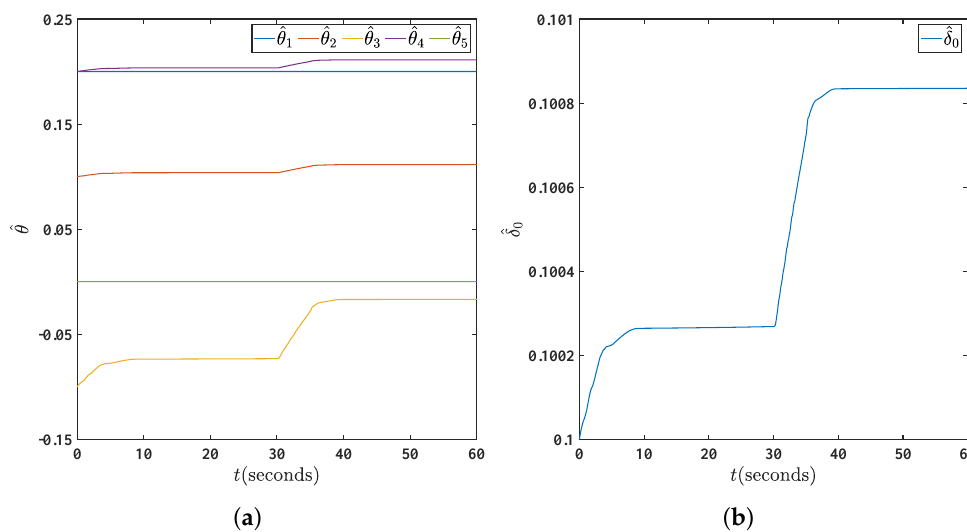
Figure 8. ( a ) Responses of parameter ˆ θ ( t ) using the proposed methodology in fault case with ρ 3 = 0, σ 3 = 1, ρ 5 = 0.6. ( b ) Responses of parameter ˆ δ 0 ( t ) using the proposed methodology in fault case with ρ 3 = 0, σ 3 = 1, ρ 5 = 0.6.